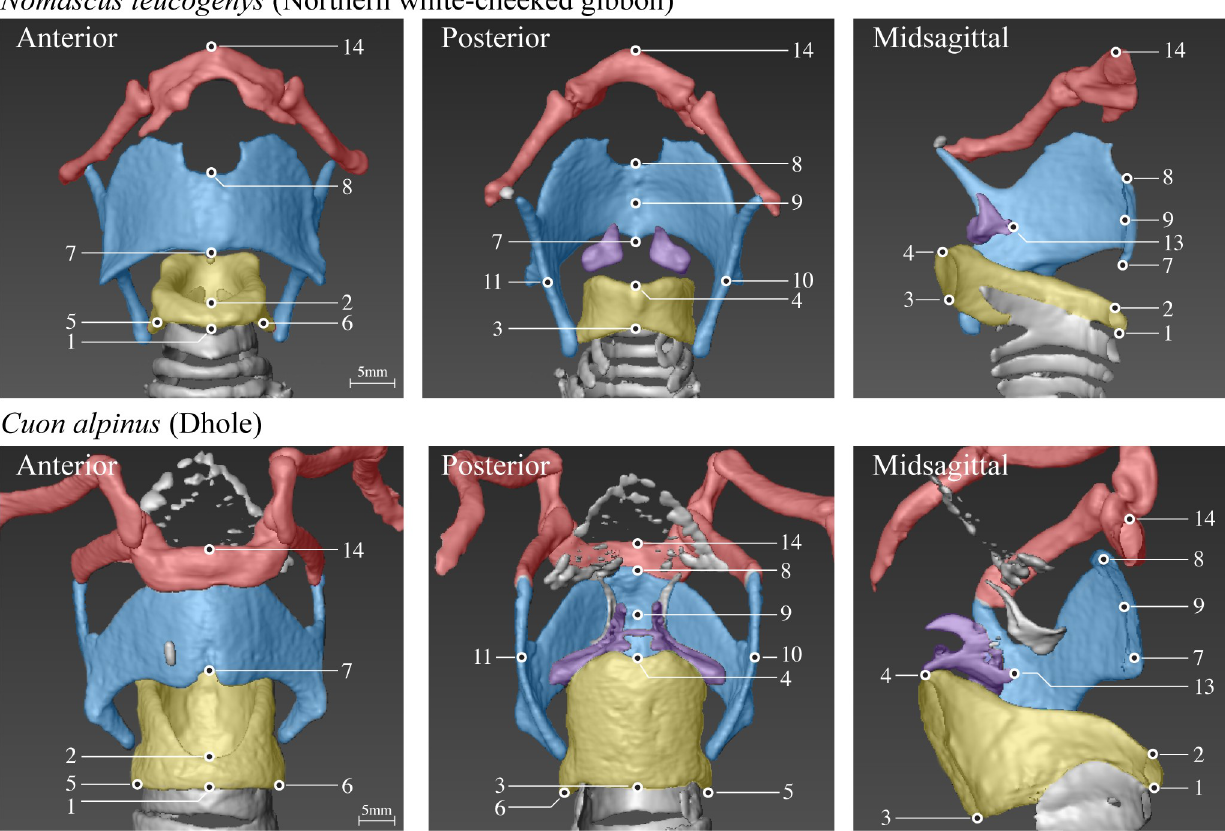
Fig 1. Laryngeal landmarks. Three-dimensional digital larynx models from our data set showing a primate larynx (top row) and a carnivoran larynx (bottom row), each from three perspectives. The cricoid cartilage is shown in yellow, the thyroid cartilage in blue, the arytenoid cartilages in purple, and the hyoid bone in red (gray epiglottal and tracheal cartilages were not assessed). Midsagittal perspectives (right panels) show the left halves of each larynx, with the ventral aspects pointing right. The 14 anatomical landmarks placed on each larynx model (see Methods) are depicted as black circles. Note that landmark 12 is not depicted here, but located on the ventral tip of the right arytenoid vocal process in a location corresponding to landmark 13, but on the right side. Table 1 describes the 10 measurements derived from these